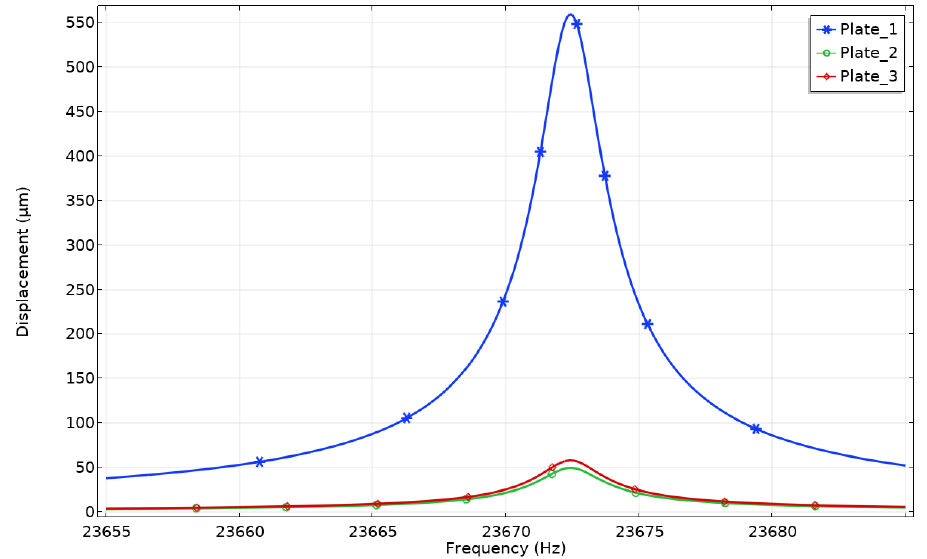
Figure 8. Displacement-frequency characteristics of the platform while Plate 1 is excited. It can be seen that the contact point (CP) located on the exciting plate has a displace- ment amplitude of 561.12 µ m while contacts points (CP) located on Plate 2 and Plate 3 plates have 56.45 µ m and 48.19 µ m displacement amplitudes, respectively.